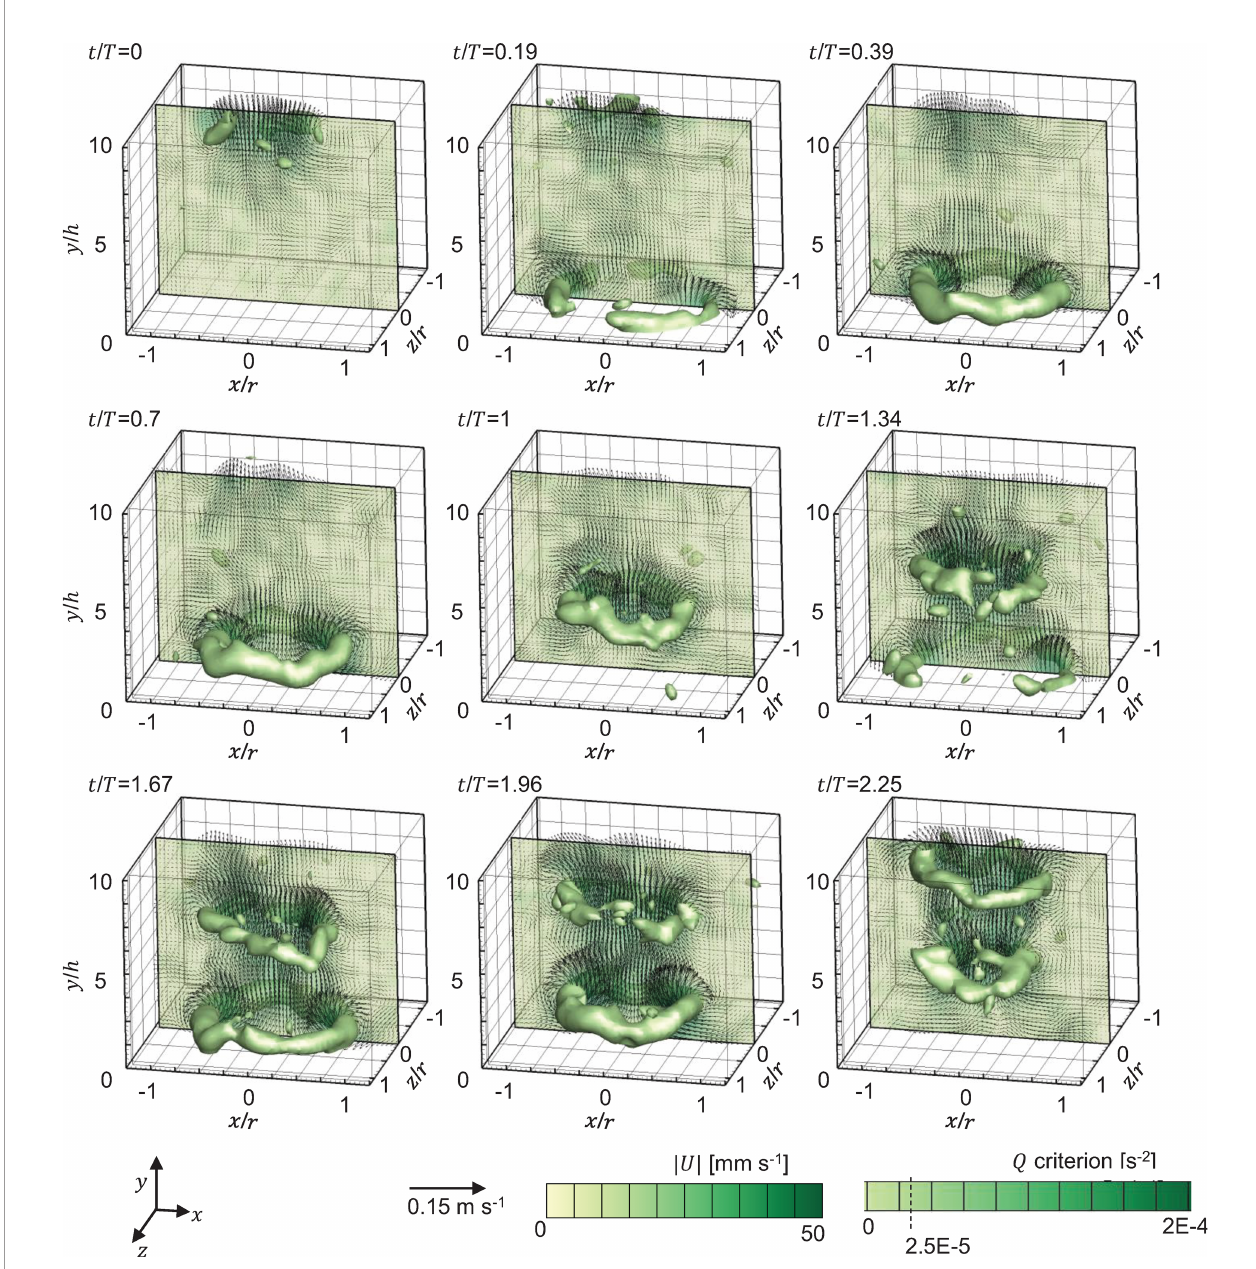
FIGURE 5 | Flow generated by pulsations of a Cassiopea medusa with no oral arms, visualized via Q – criterion isosurfaces (at Q = 2.5×10 -5 s -2 ), obtained from 3D PTV measurements. Contours are overlaid with in-plane velocity vectors at z / r = 0. Flow fi elds from two consecutive pulsation cycles are shown. Non-dimensional time ( t / T ) is de fi ned relative to the time period ( T ) of the fi rst bell pulsation cycle (=1.18 s). Time points shown for the fi rst bell pulsation cycle ( T ≈ 1.18 s) include: 0% PS ( t / T = 0), 50% PS ( t / T = 0.19), 100% PS ( t / T = 0.39), 50% RS ( t / T = 0.7) and 100% RS ( t / T = 1). Time points shown for for the second bell pulsation cycle ( T ≈ 1.46 s) include: 50% PS ( t / T = 1.34), 100% PS ( t / T = 1.67), 50% RS ( t / T = 1.96) and 100% RS ( t / T = 2.25). PS, power stroke (bell contraction); RS, recovery stroke (bell larger for the medusa resting on the substrate. Figure 9 shows that d bell , and (iii) 1.5 d bell above the jelly fi sh and the vertical centerline. both with and without a substrate, the strongest fl ows occur along Each plot provides the data at the beginning of and throughout the the centerline ( x =0) and vary throughout the cycle. Furthermore, 4th pulsation cycle at 0%, 20%, 40%, 60%, 80%, and 100% of the the magnitude of velocity peaks as each vortex moves over the cycle. As suggested previously, the upward jet is stronger when the horizontal line. This phenomenon can be observed in Figure 10 substrate is present as the peak magnitude of velocity is typically